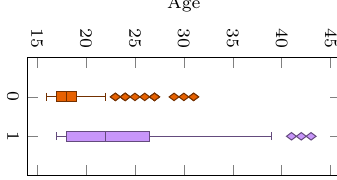
Figure 4. Age importance box plot (red: success, magenta: dropout).